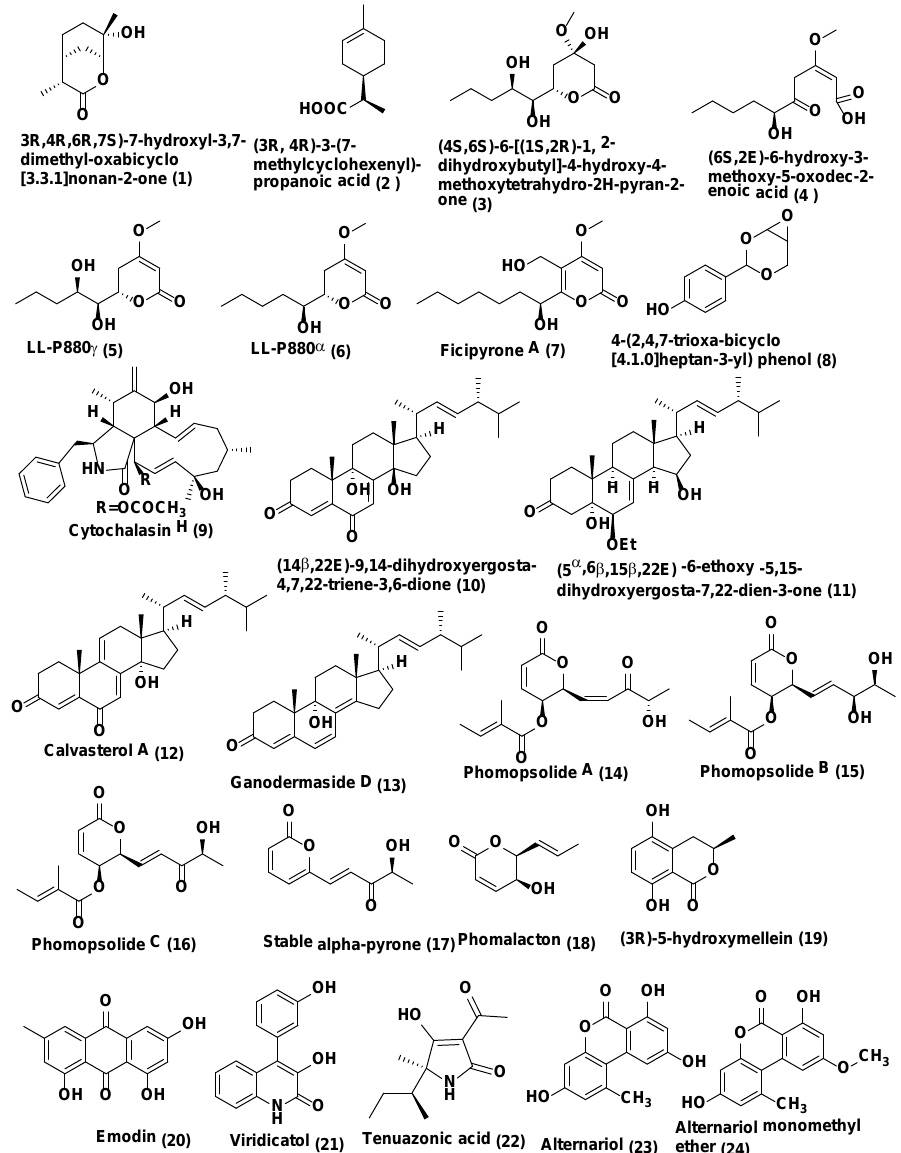
Figure 1. Structures of metabolites isolated from Coelomycetes ( 1 – 24 ).